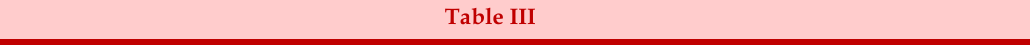
Effect of Berberis calliobotrys on complete Freund’s adjuvant -induced arthritis in rats